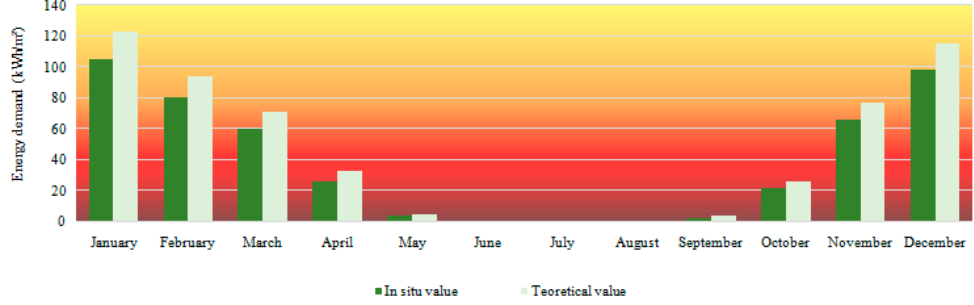
Figure 6. Monthly heating energy demand according to EnergyPlus.